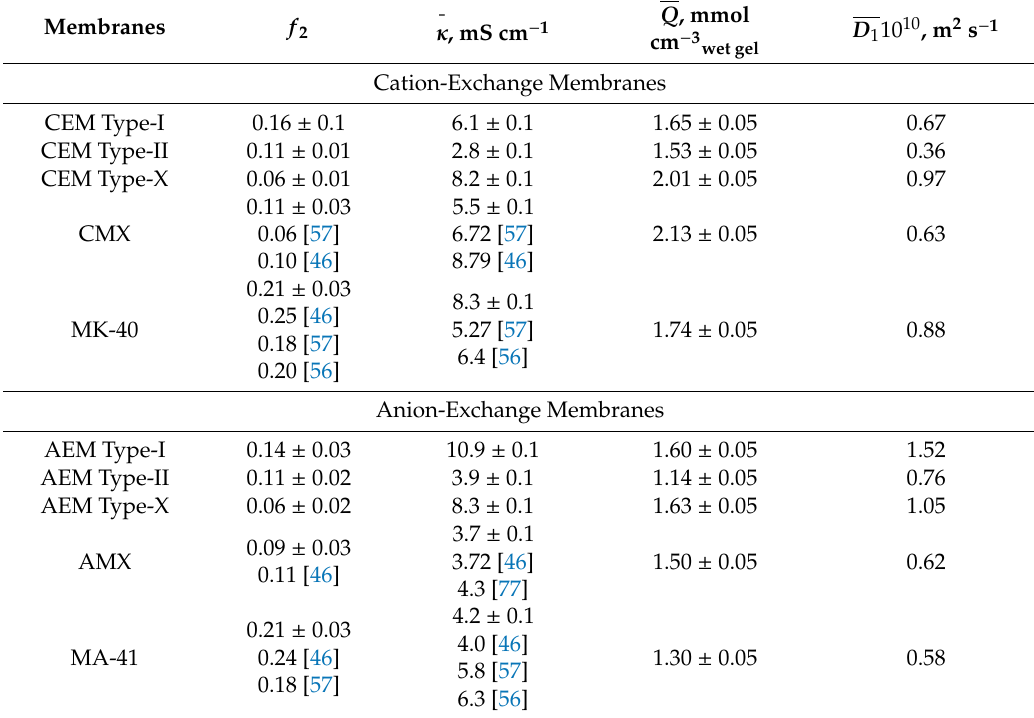
Table 4. The values of conductivity at the isoconductivity points, volume fraction, exchange capacity of and counterion di ff usion coe ffi cient in the gel phase of the investigated membranes in NaCl solution.